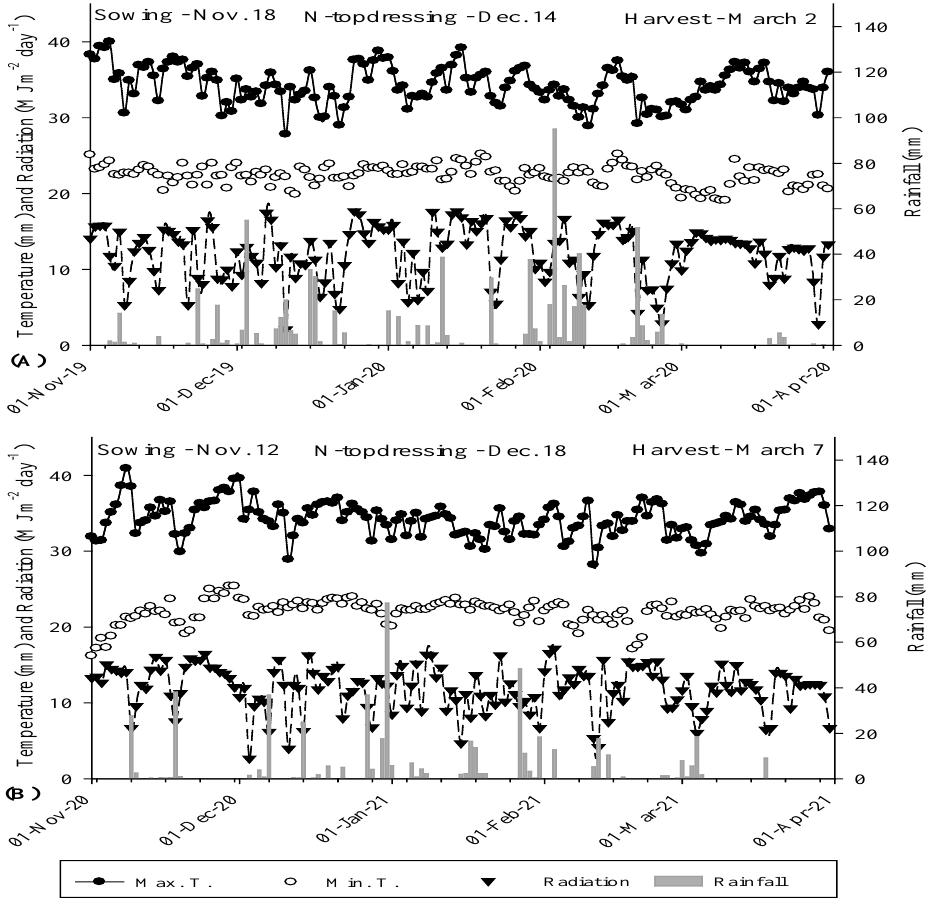
Figure 5. Rainfall, maximum, and minimum temperatures, and light radiation were acquired from